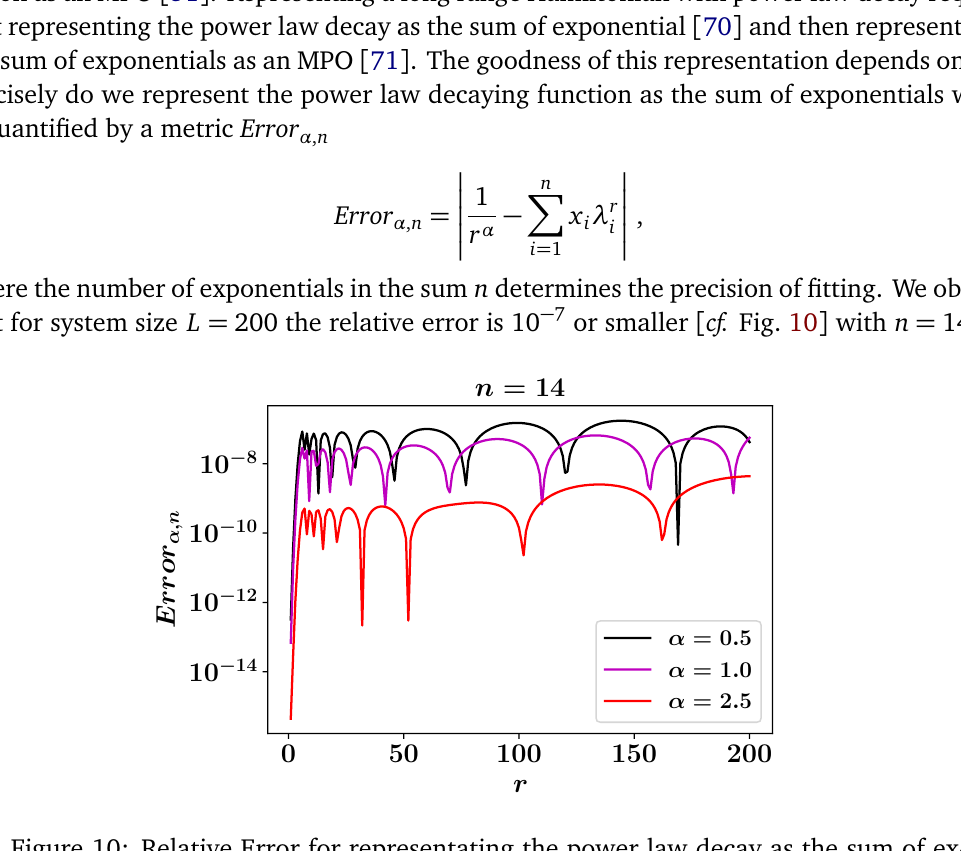
Figure 10: Relative Error for representating the power law decay as the sum of ex- ponential for three representative values of interaction range α = { 0.5,1.0,2.5 }